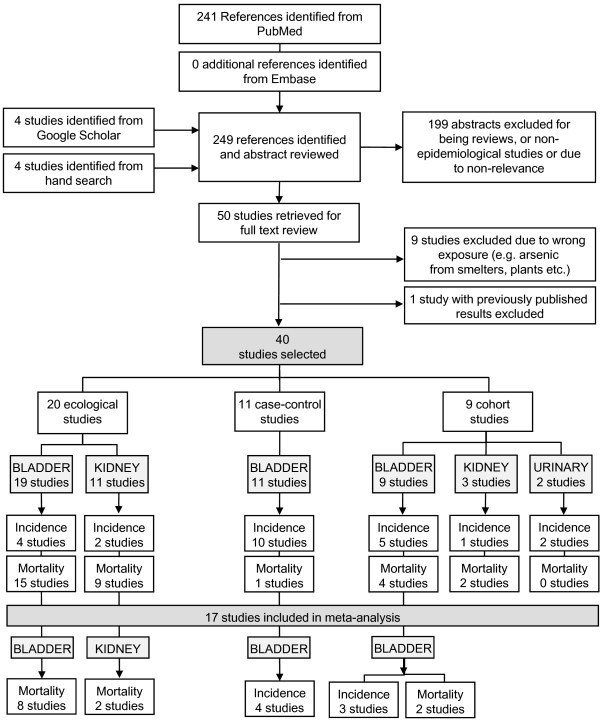
Study selection process. Note that several studies report on more than one cancer site.